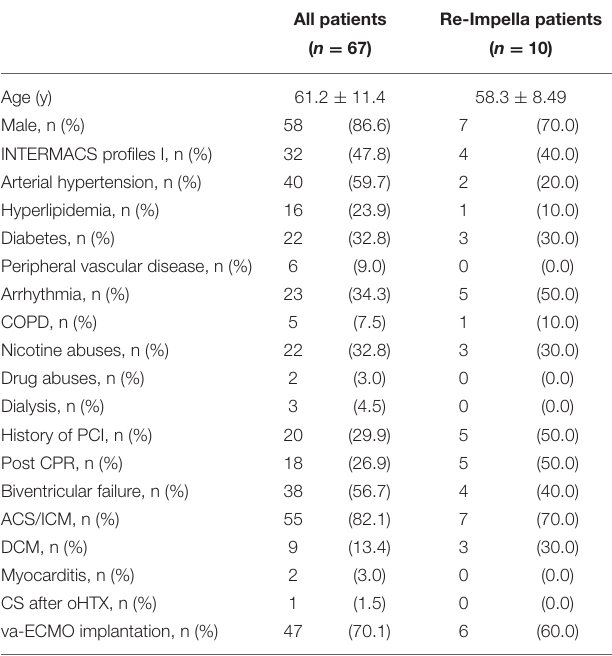
TABLE 1 | Baseline clinical characteristics.